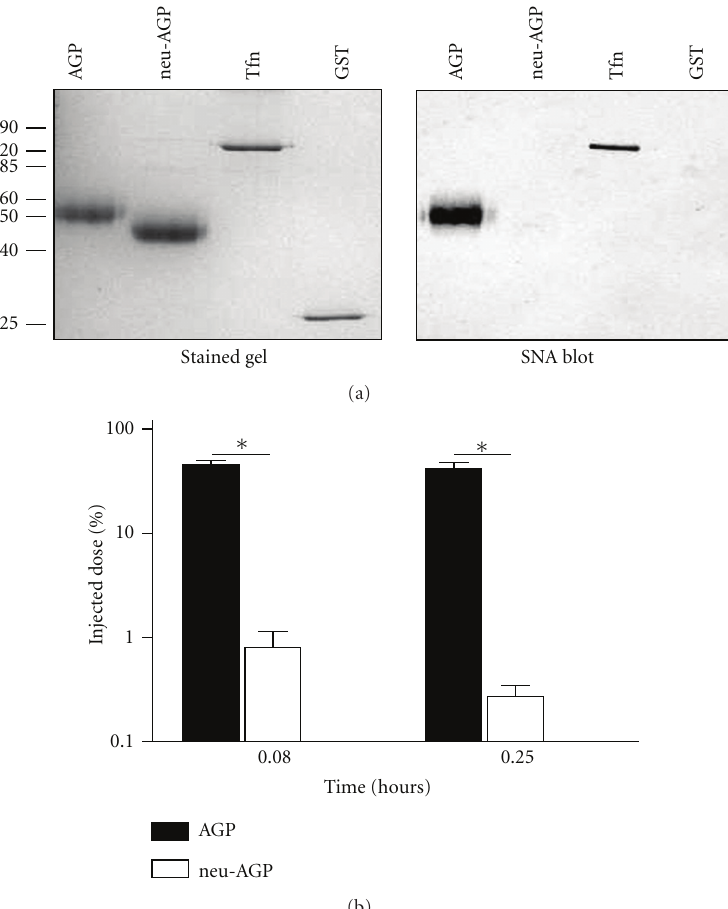
Figure 1: Neuraminidase treatment of human AGP increases its clearance from the rabbit circulation. Plasma-derived AGP with (neu-AGP) or without (AGP) neuraminidase treatment was examined on a 12% SDS reducing gel, either by Coomassie Blue staining ((a), left, stained gel) or by ligand blotting with SNA ((a), right, SNA blot). The position of molecular mass markers is shown in kDa, at left. Tfn: transferrin; GST: glutathione sulfotransferase. (b) Shows the recovery (% injected dose) of acid-precipitable radioactivity in plasma at di ff erent times following injection of radioiodinated AGP (solid bar) or neu-AGP (open bar) into rabbits. ∗ Indicates P < 0 . 05 versus corresponding AGP value by unpaired t -test, Welch corrected. The mean of 7 determinations ± SD is shown.